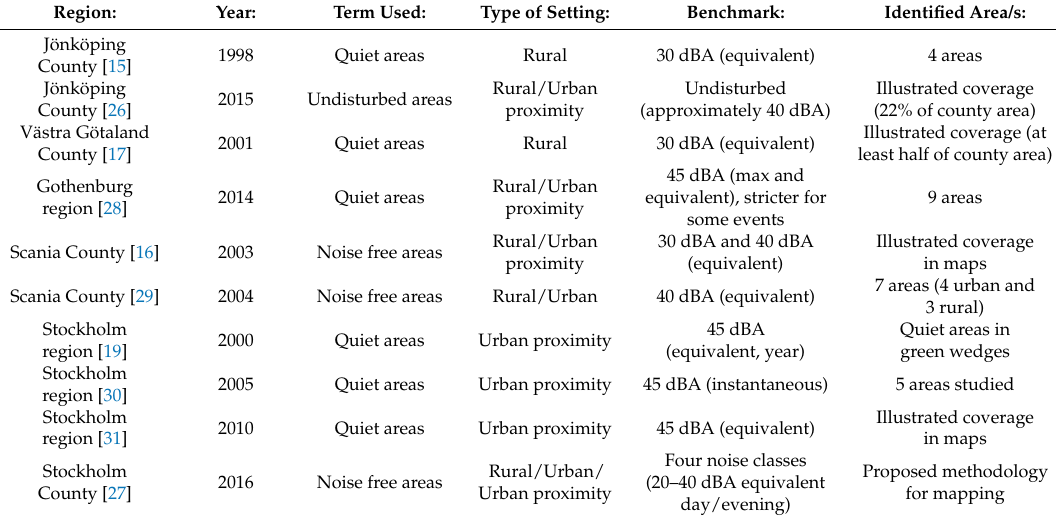
Table 1. Overview of regional ‘quiet area’ initiatives in